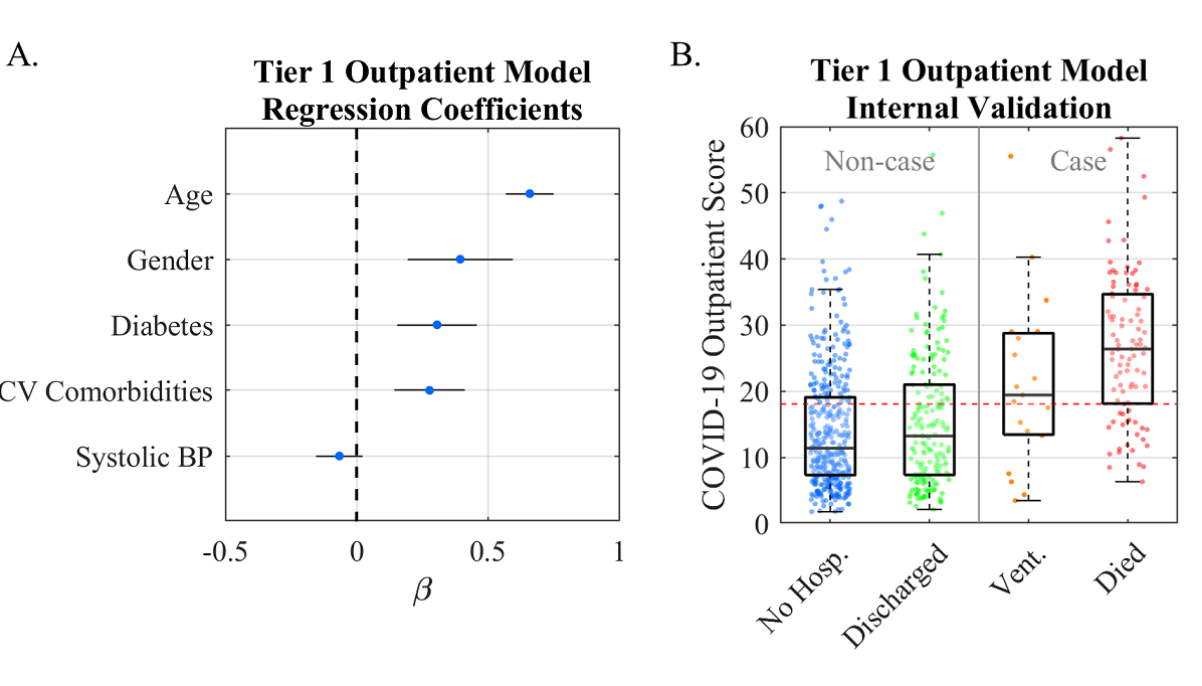
Figure 2. Validation of the Tier 1 Outpatient Model. A. Lasso logistic regression coefficients revealing the relative importance of predictors in generating the score. B. Box/scatter plot from the internal validation showing the Tier 1 Outpatient Scores for the four outcomes. A cutoff score of 18 (red dotted line) balances sensitivity and specificity for “Noncase” vs “Case” patients (gray line). COVID-19: coronavirus disease; CV comorbidities: cardiovascular comorbid conditions; No Hosp.: patients who were not hospitalized; Vent.: patients who were ventilated.